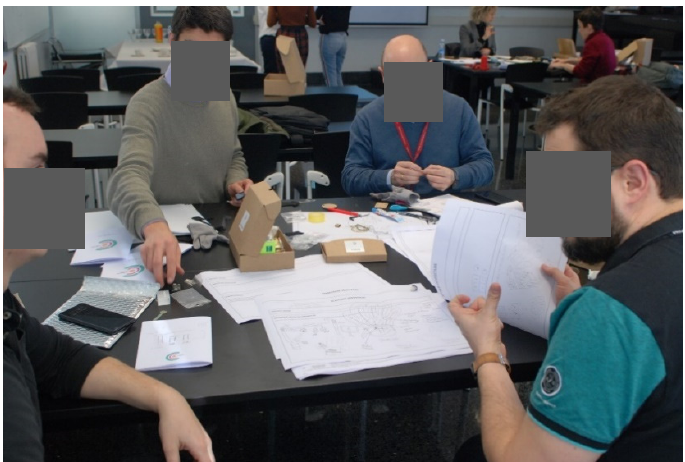
Figure 16. Participants from Group 2 completing the templates.